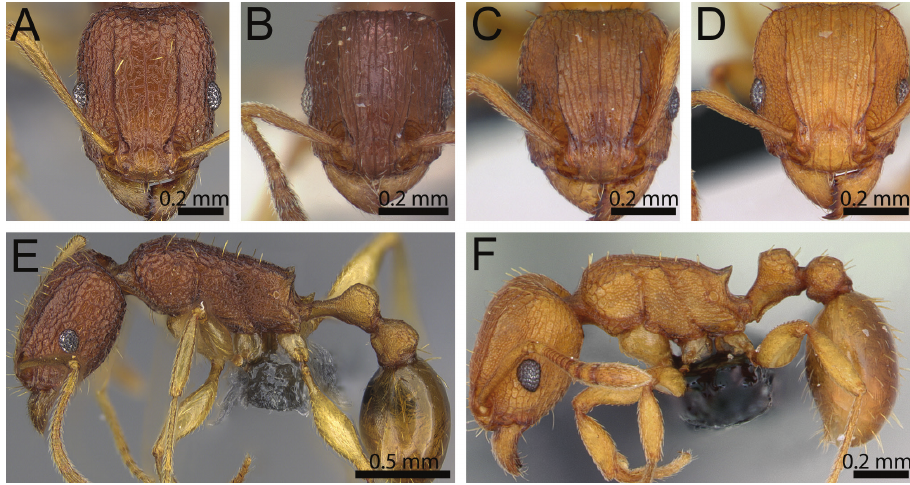
Figure 6. Head in full-face view and body in profile. A, E T. cavernicola (CASENT0373132) B T. scytalum